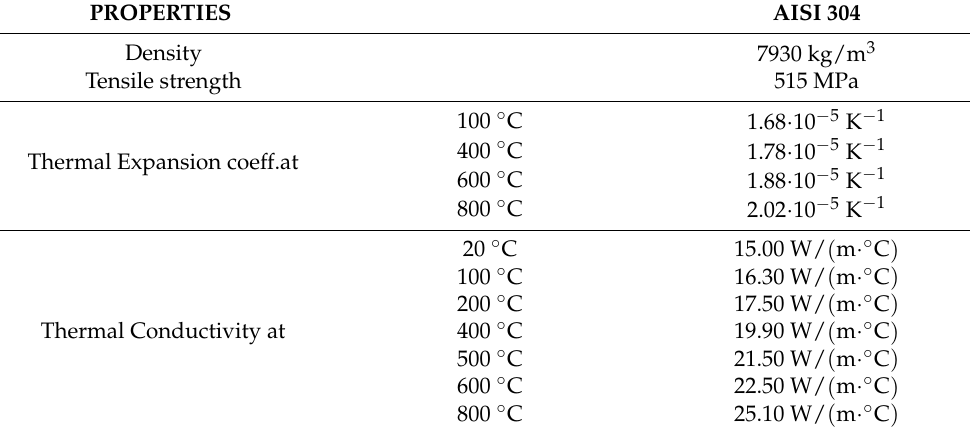
Table A3. Mechanical and thermal properties of AISI 304. See